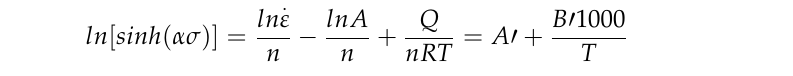
Figure 4. Correlation between lnZ parameter and ln[sin h( ασ )] under true strain of 0.5.